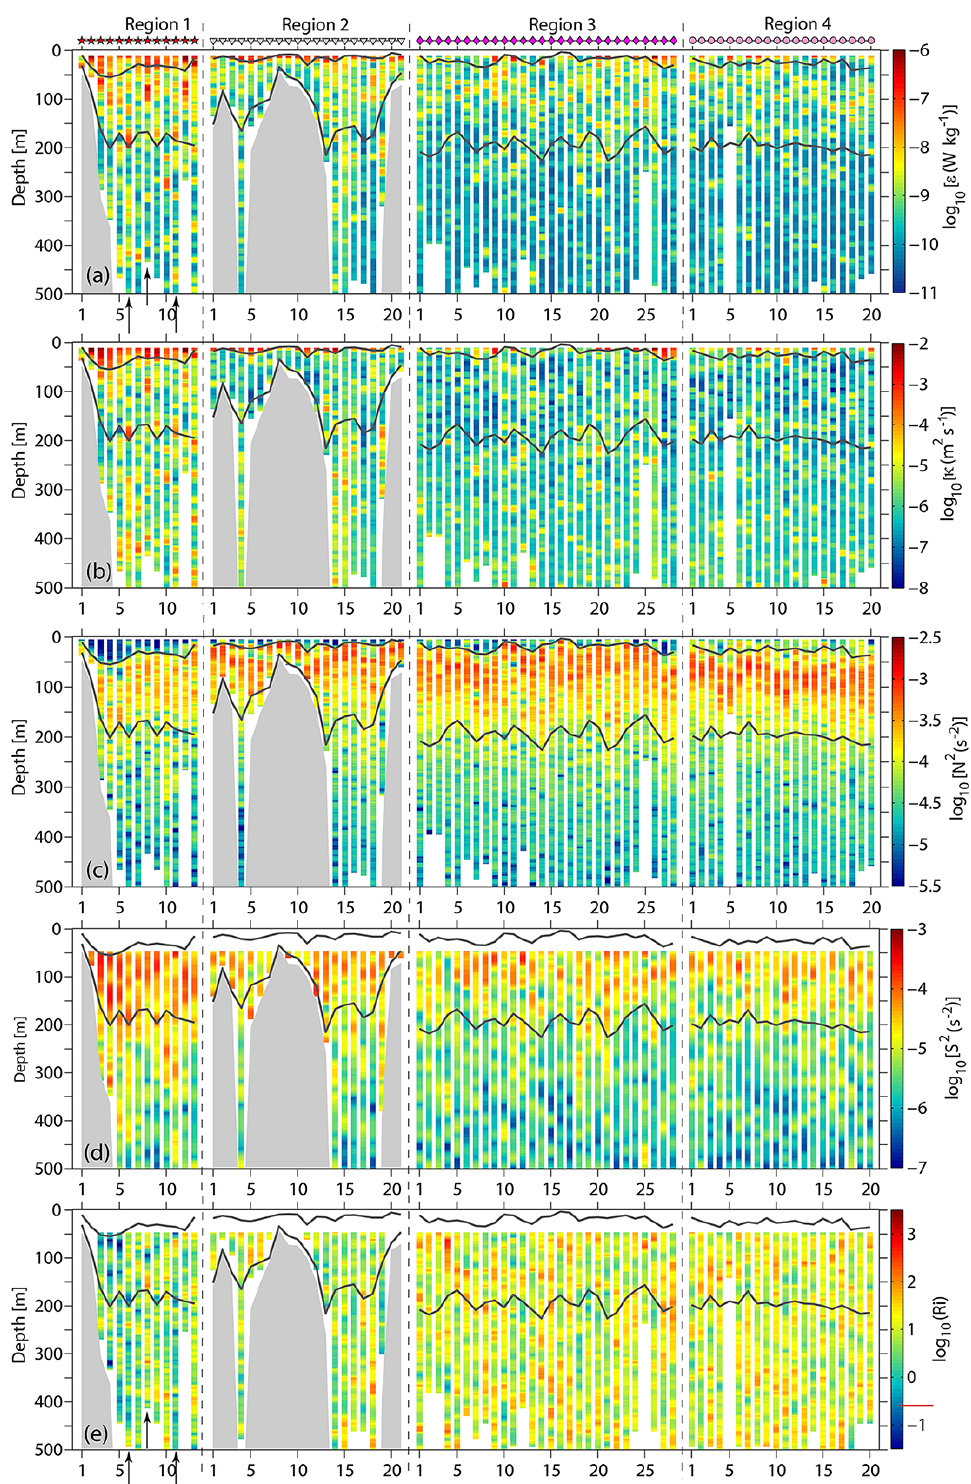
Figure 4. (a) Dissipation rate ( ε) , (b) diapycnal diffusivity ( κ) , (c) buoyancy frequency squared ( N 2 ) , (d) shear variance ( S 2 ) , and (e) Richardson number ( Ri) from all of the stations. The gray shading indicates the bathymetry. In (a) – (e) the boundaries of the thermocline are indicated (gray curves). The red line on the color bar of (e) represents Ri = 0.25. The vertical dashed lines divide the stations into four regions with the symbols (red stars, gray triangles, magenta diamonds, and pink dots) shown at the top of (a) . These symbols correspond to the station symbols in Fig.